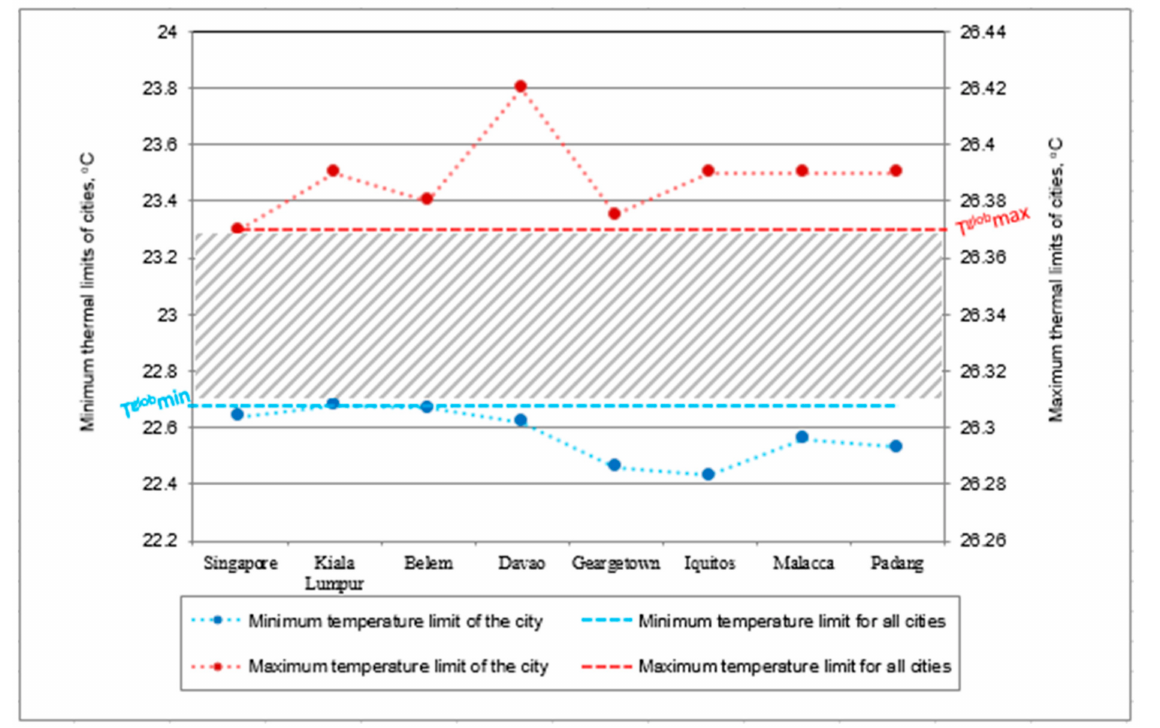
Figure 4. Minimum and maximum thermal limits for each city and global thermal comfort limits.